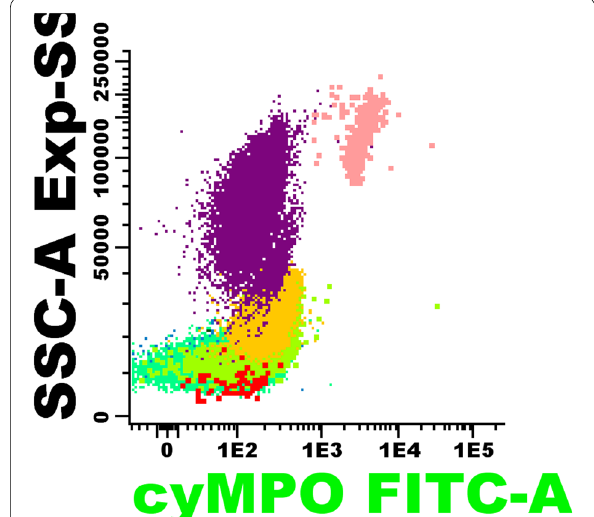
depicted in Fig. 4, where flow cytometry shows different white cell populations as polymorphonuclear neutro- phils and monocytes negative for MPO fluorescence, as an incidental finding as shown. This discovery correlates with the presence of Large Unstained Cells (LUC)/false neutropenia in the complete blood count, with a normal peripheral blood smear.